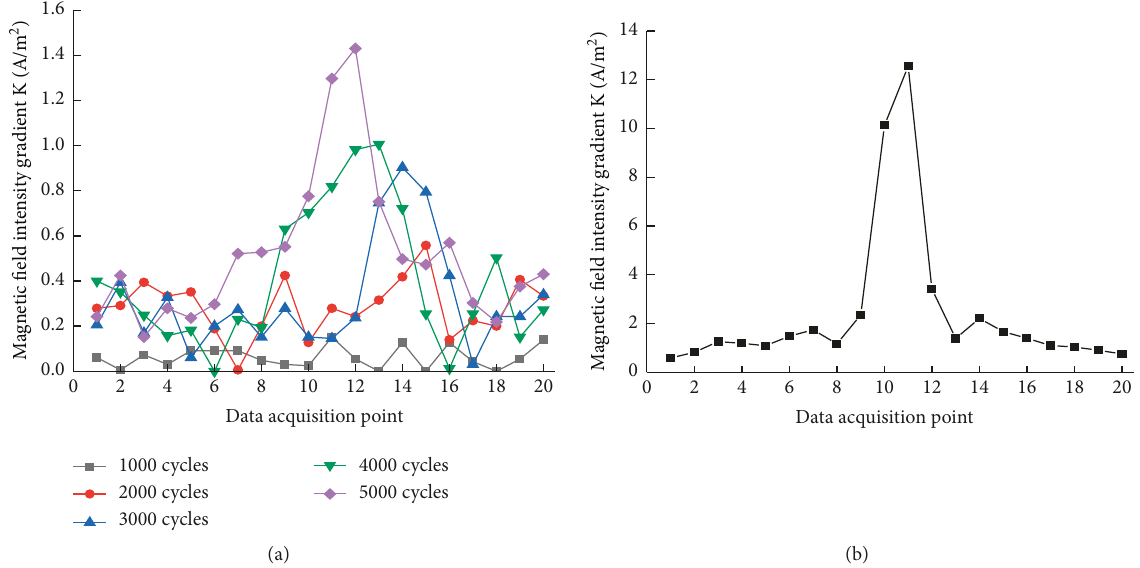
Figure 8: K curves corresponding to each fatigue damage stage. (a) 1000–5000 cycles. (b)